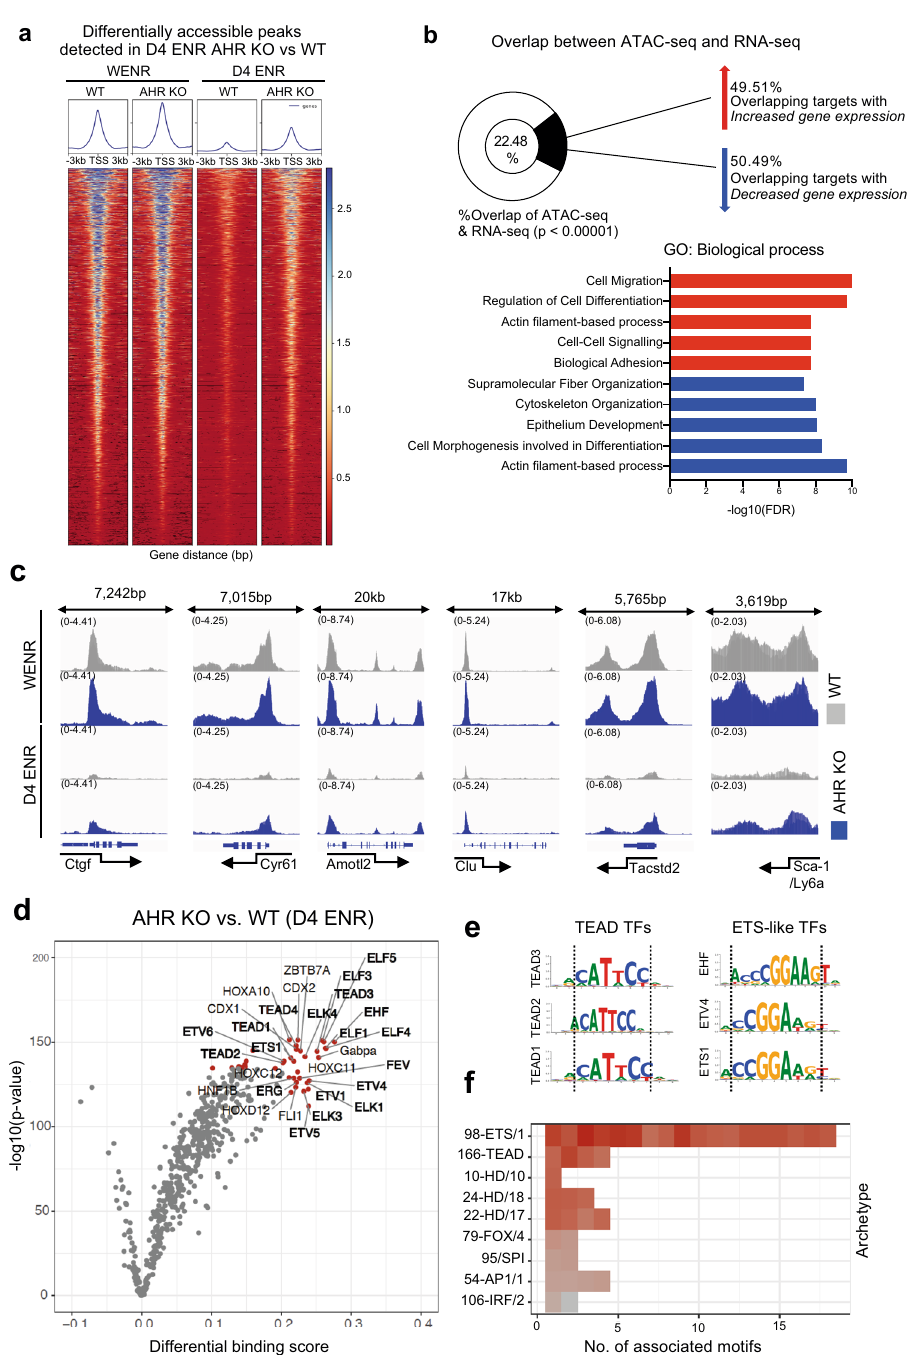
Fig. 4 AHR restricts genomic accessibility to Yap/Tead targets. a Deeptools heatmap showing accessibility data of differentially expressed peaks identi fi ed in d4 ENR AHR KO vs WT organoids across samples (FDR < 0.05) ( b ) GO gene ontology (biological process) was conducted on genes that overlap between differentially accessible targets identi fi ed by ATAC-seq and differentially upregulated or downregulated genes in AHR KO vs WT organoids grown in D4 ENR conditions as determined by RNA-seq (FDR < 0.05). Statistical signi fi cance was determined by permutation testing of the overlap between the datasets ( p value <0.00001). c IgV images of accessibility peaks (open regions) of known Yap/Tead targets ( Ctgf , Cyr61 , Amotl2 ) and fetal-like genes ( Clu , Tacstd2 , Ly6a ) in d4 ENR WT and AHR KO organoids ( d ) Pairwise comparison of TF activity between differentiated AHR KO and WT organoids (d4 ENR). The volcano plots show the differential binding activity against the – log10 ( p value) of all investigated TF motifs represented by a dot. Only the top 5% (both by fold-change, -log10 p value) of TF motifs identi fi ed are highlighted in red. TFs belonging to Tead and Ets-1 like family of factors are bolded. e Motif sequences of some identi fi ed TFs belonging to Tead ( Tead 3, Tead4, Tead1 ) and Ets-1 family are shown, and the dotted line highlights the similarity in the binding sequence of these factors ( f ) Top 5% of identi fi ed motifs were aligned to each other and matched to an archetypal consensus motif. The color represents the fold-change (Red to grey – highest to lowest) in differential binding score between d4 AHR KO vs WT organoids. Source data for (4b, d) are provided with this paper in the source data fi